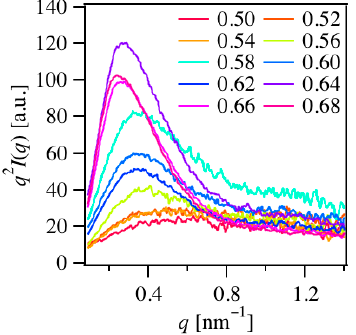
Figure 8. Kratky plots of the carboxylated SR gels at φ a = 0.50–0.68.